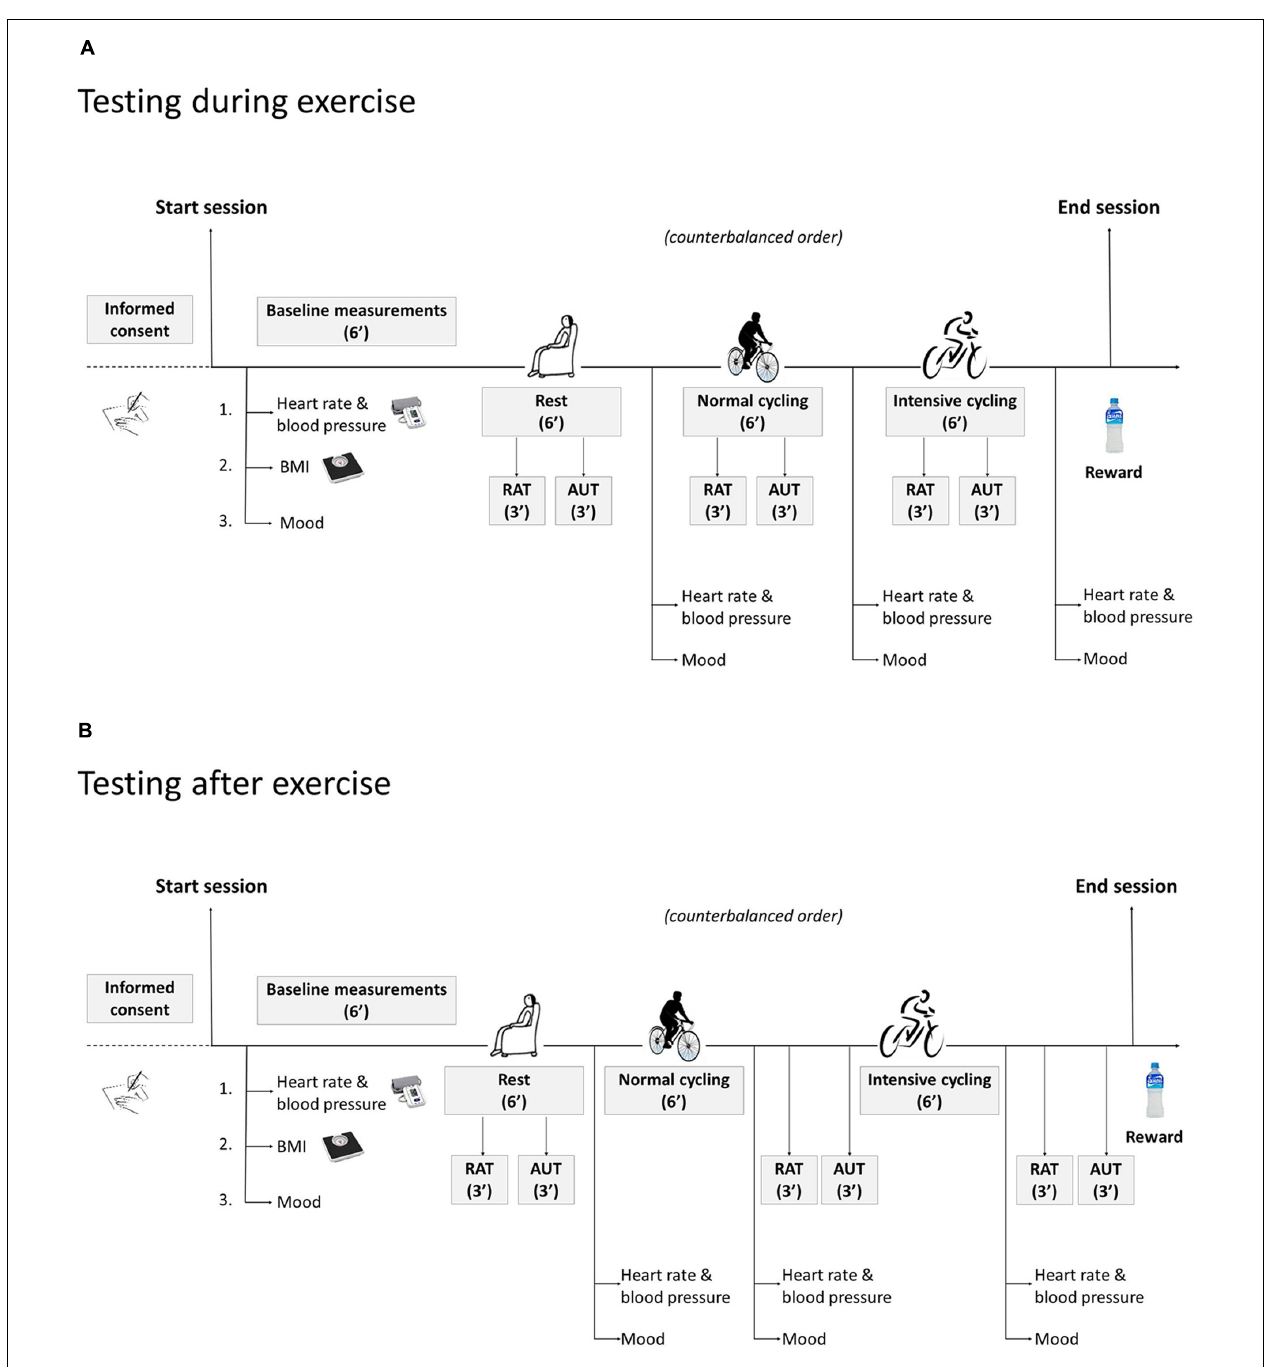
FIGURE 1 | Sequence of events for the participants who performed the creativity tasks during exercise (A) or after exercise (B).